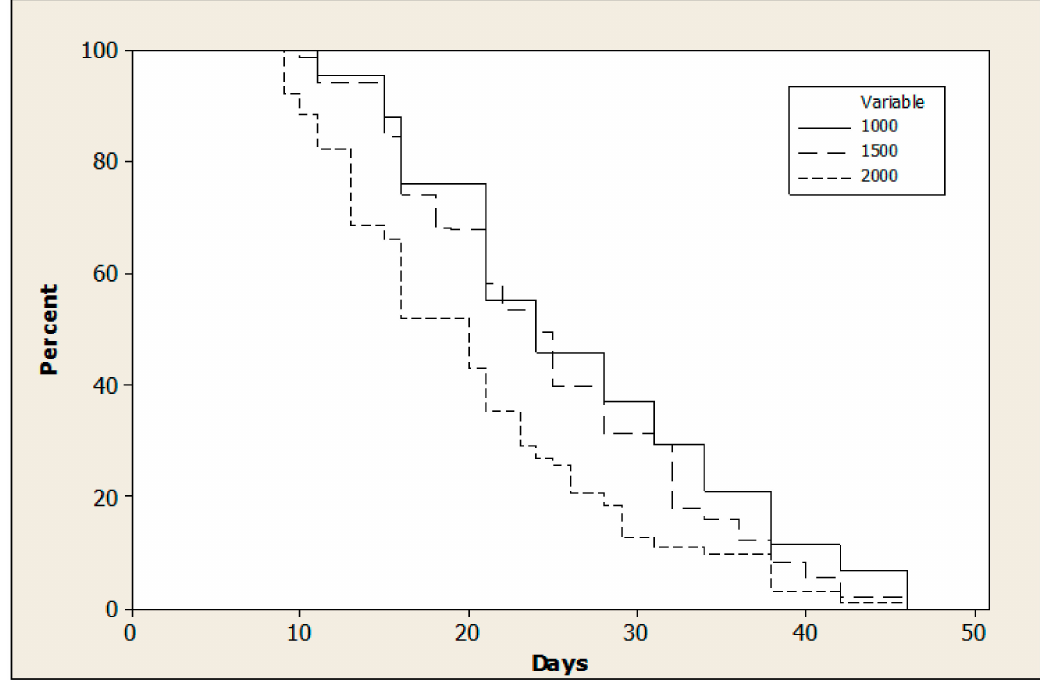
Figure 1. Survival curves of adults according to three di ff erent cage densities: 1000, 1500, and 2000 adults with a ratio of one male for three females in standard rearing cages (30 × 30 × 30 cm) with continuous access to 5% (wt:vol) sucrose